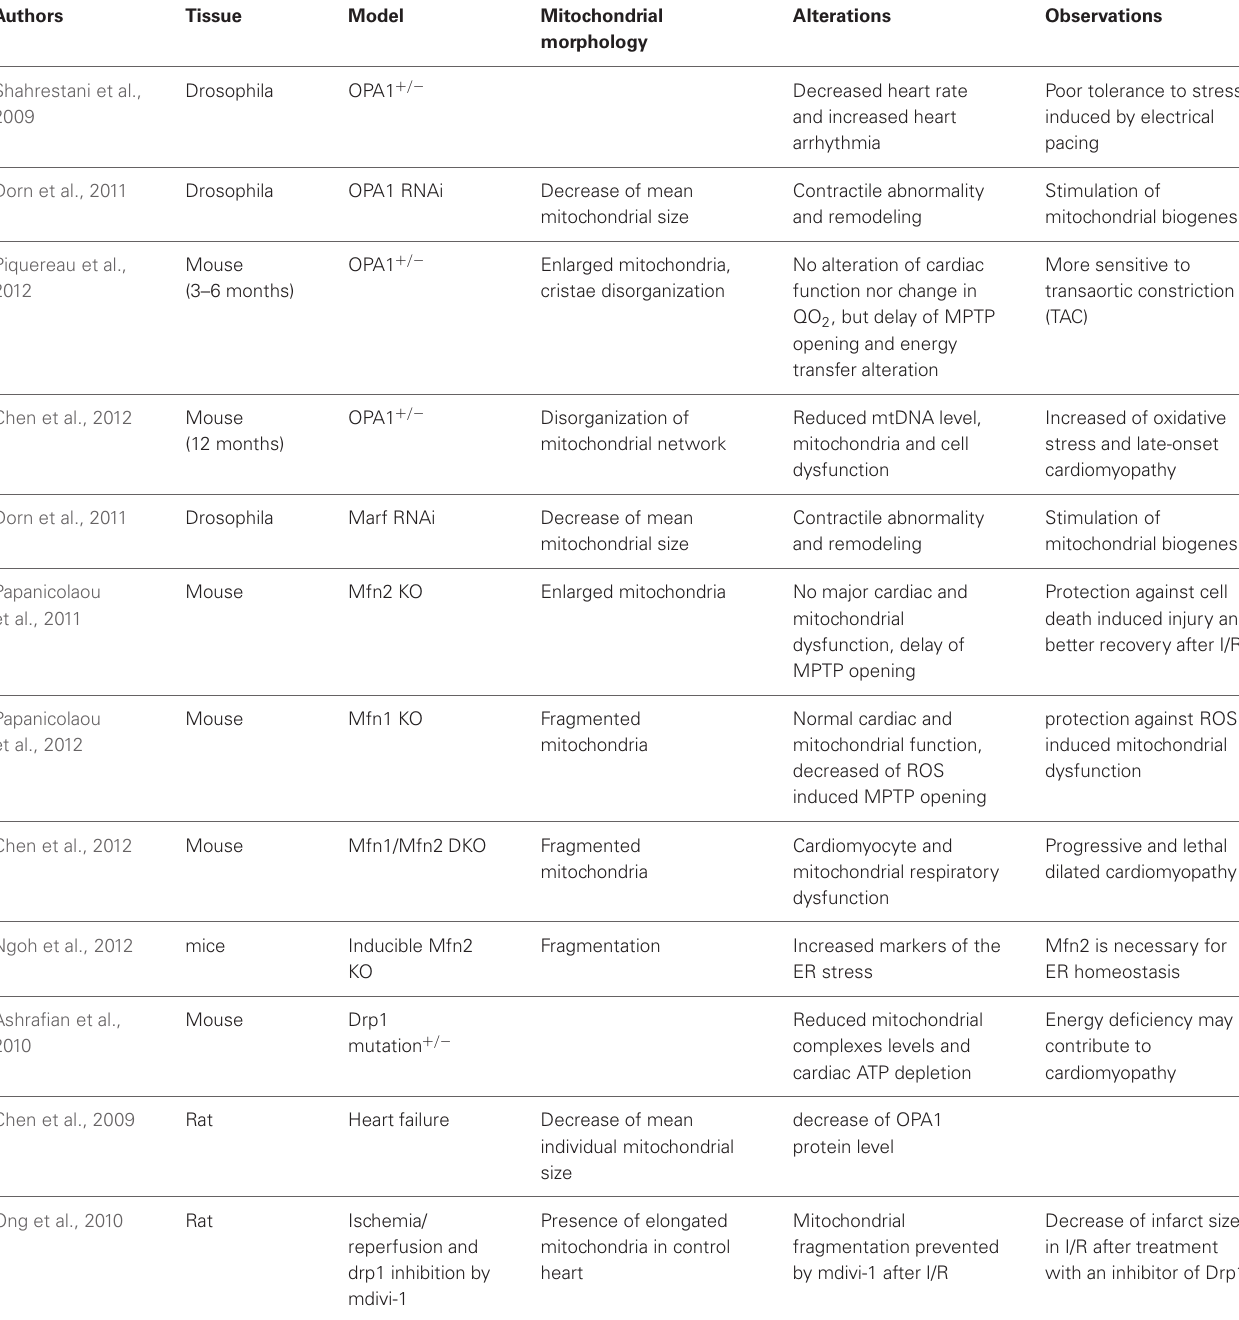
Table 1 | Mitochondrial dynamic studies on the mature